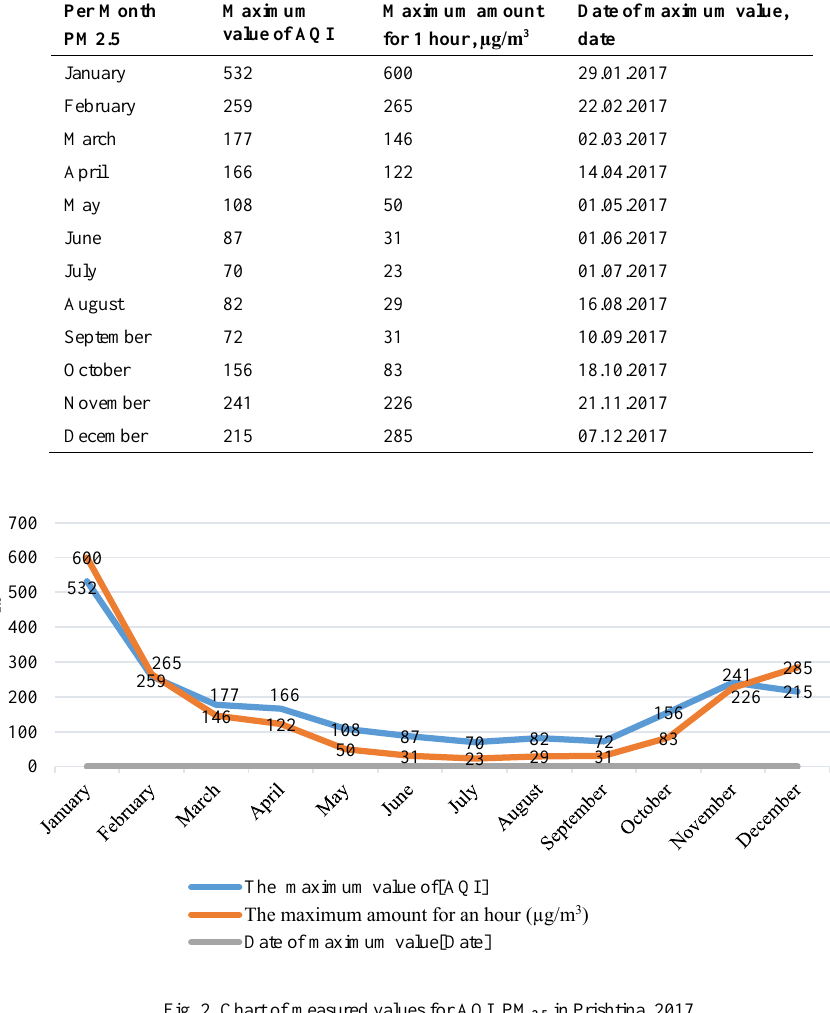
Fig. 2. Chart of measured values for AQI, PM 2.5 in Prishtina,